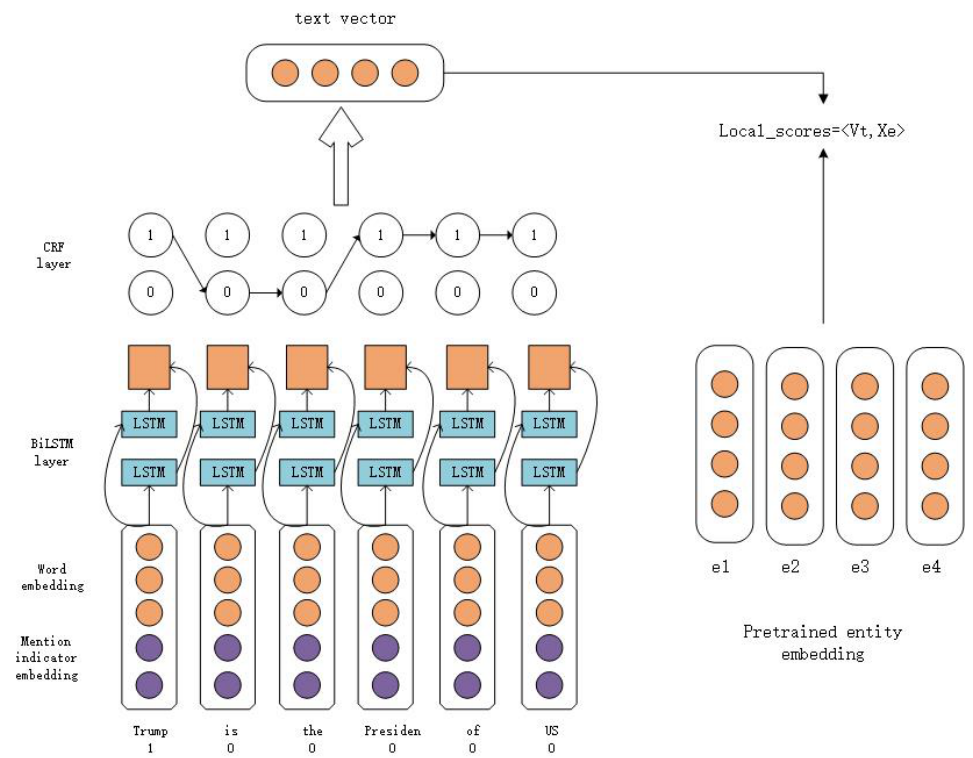
Figure 5. Local model with a novel CRF-based attention mechanism. The inputs of this model